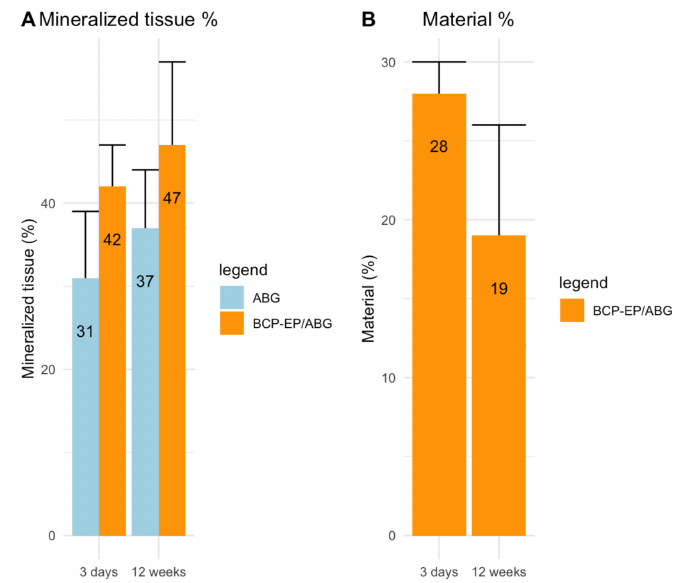
Figure 7. Graphs of the histomorphometrical analysis after 3 days and 12 weeks of implantation of ABG (light blue) or BCP-EP/ABG (orange): ( A ) mineral tissue percentage and ( B ) material resorption. Mineralized tissue increased overtime and resorption of BCP-EP was observed. Data are shown as mean ± sd. No statistical difference was observed between ABG and BCP-EP/ABG at week